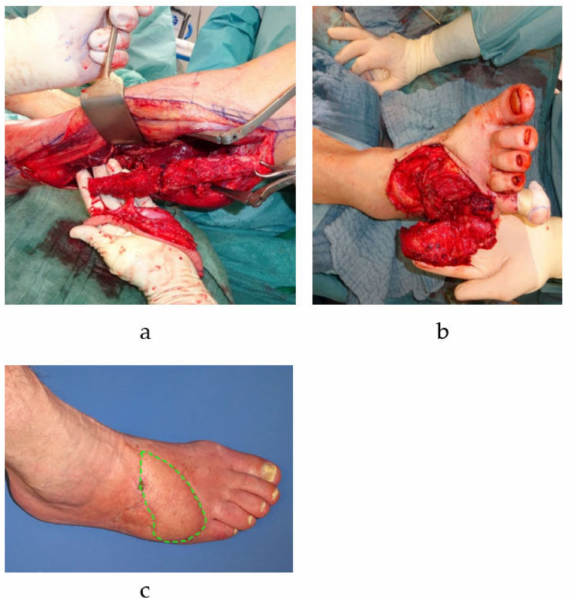
Figure 2. Free microvascular autologous bone transplantation for metatarsal defect. A free fibula transplant with a single-perforator based skin island is harvested from the left lower leg ( a ). The osteocutaneous flap is transplanted into the defect to reconstruct the fifth metatarsal bone of the right foot (vascular anastomosis is performed by connecting the flaps pedicle, i.e., the left fibular artery, to the anterior tibial artery of the right foot in an end-to-side manner) ( b ). The skin island (green dotted line) is twisted 90 degrees and is subsequently used to closes the concomitant soft tissue defect ( c